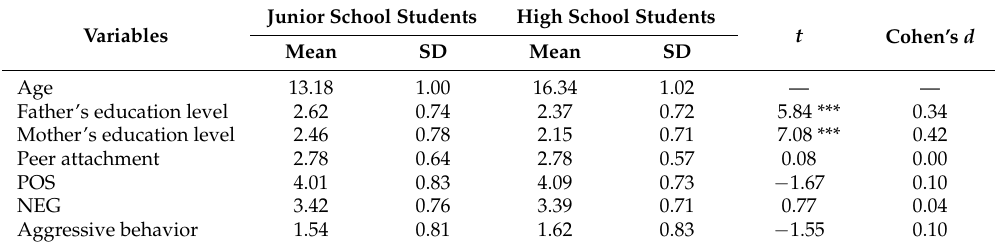
Table 2. Group differences of study variables between junior school versus high school students. Variables